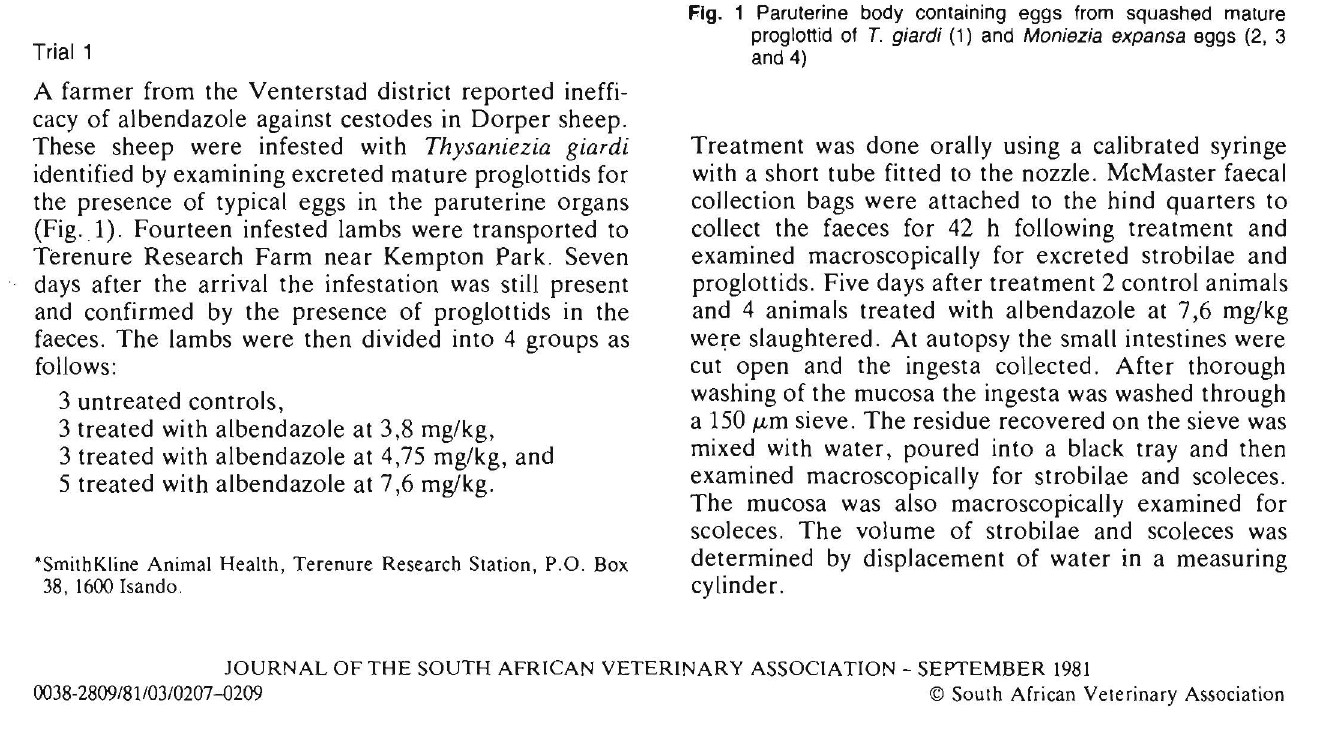
Fig. 1 Paruterine body containing eggs from squashed mature proglottid of T. giardi (1) and Moniezia expansa eggs (2, 3 and